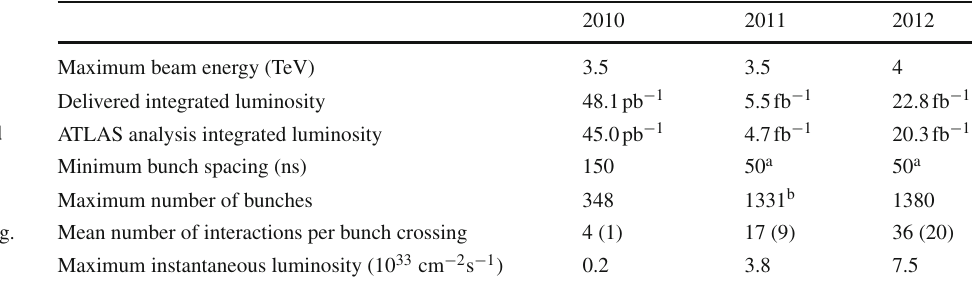
Table 1 Summary of proton collision data presented in this paper. The ATLAS analysis integrated luminosity corresponds to the